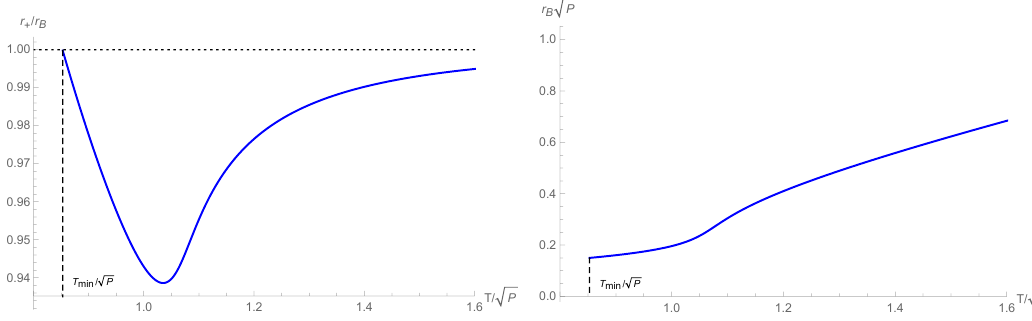
p p P against T= P for a RN black hole in a cavity